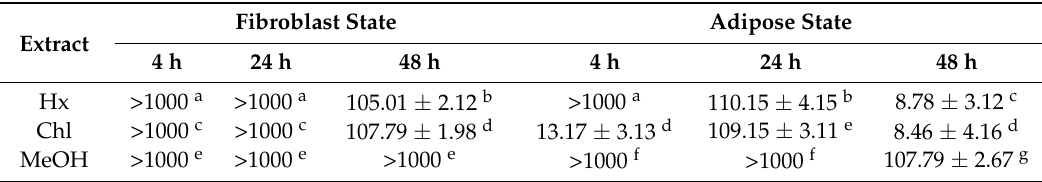
Table 2. Half maximal inhibitory concentration (IC 50 ) [ µ g/mL] of the extracts of E. menziesii against 3T3-L1 cell